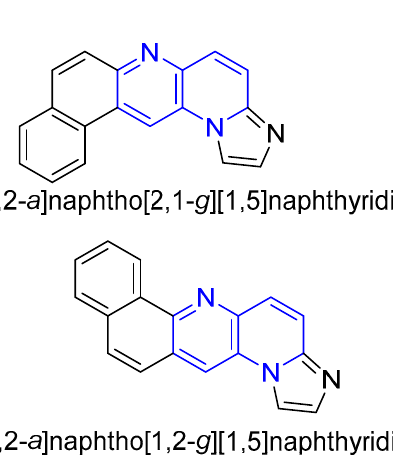
Figure 3. Examples of fused 1,5-naphthyridines with five-membered nitrogen heterocycles.